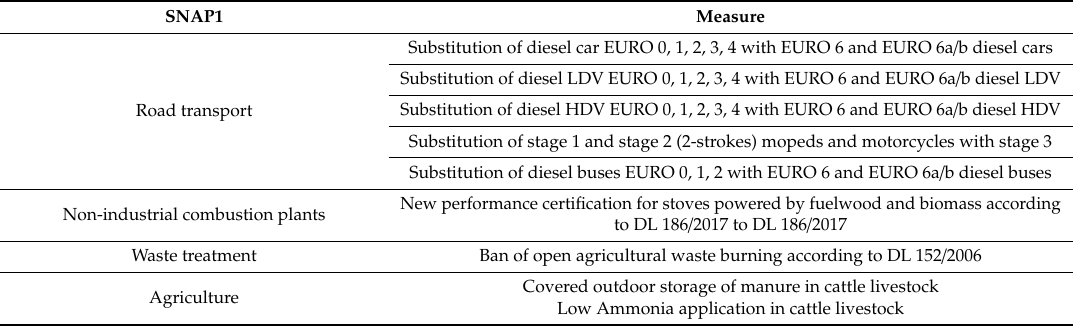
Table 1. Measures implemented in the